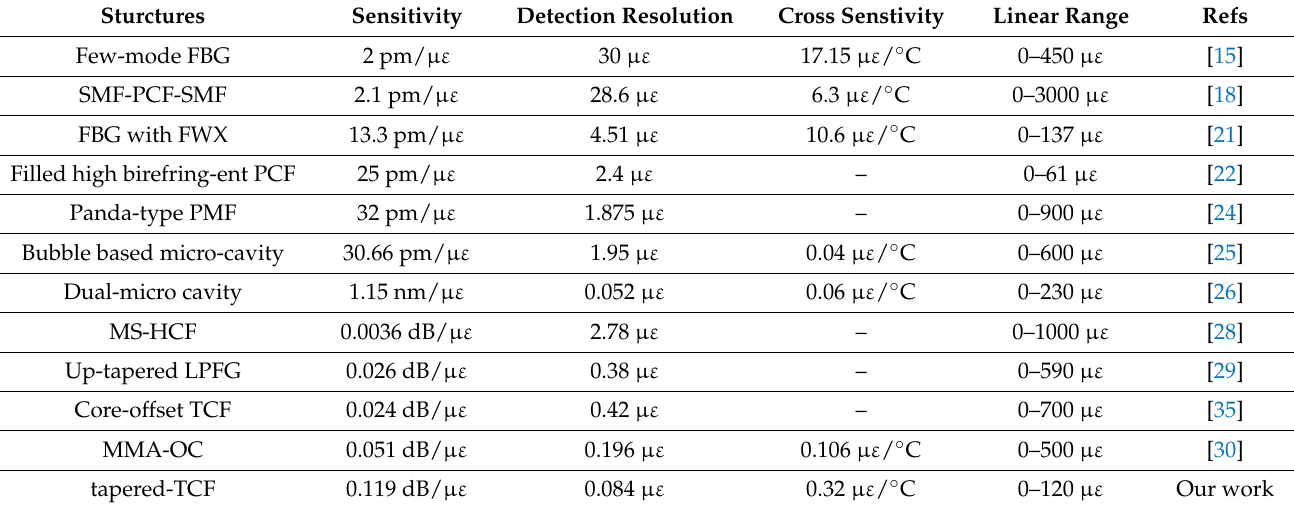
Table 3. Performance comparisons of the reported fiber-optic strain